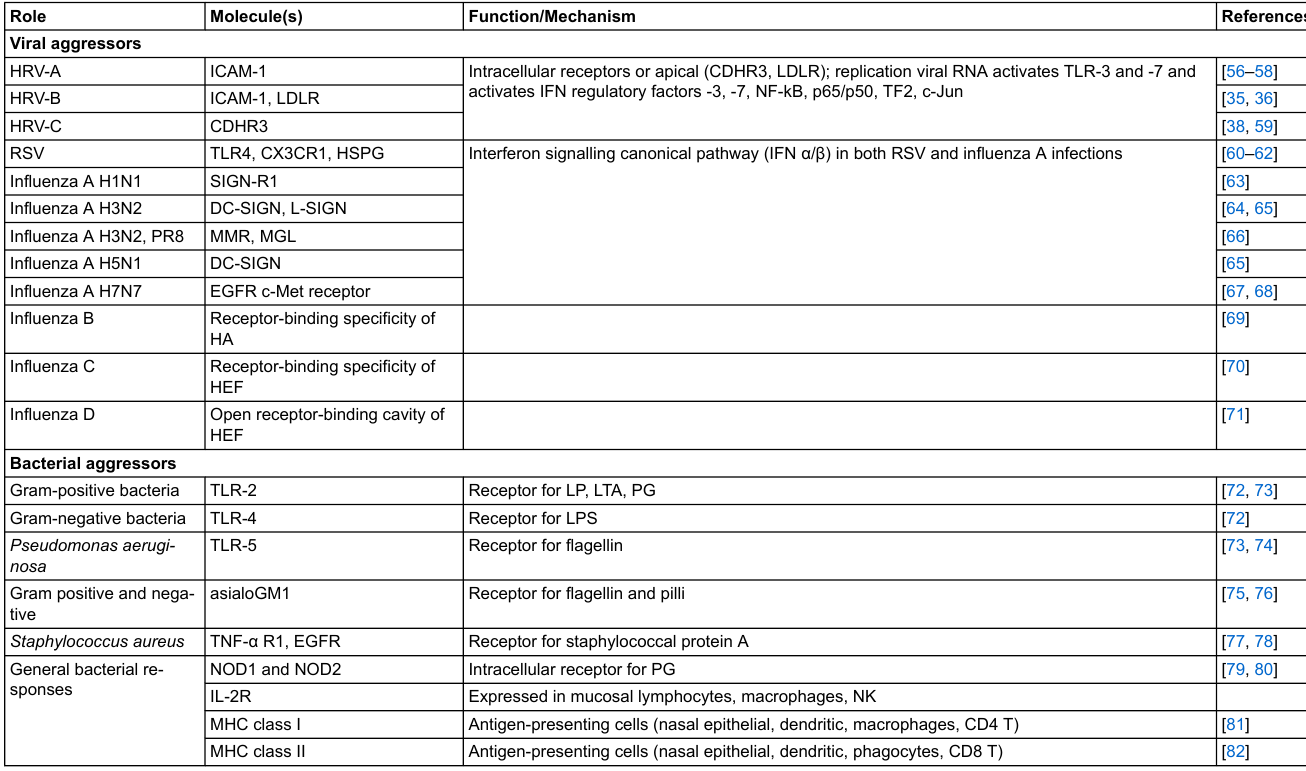
Table 2: Mechanisms deployed by viral and bacterial aggressors to invade upper airway